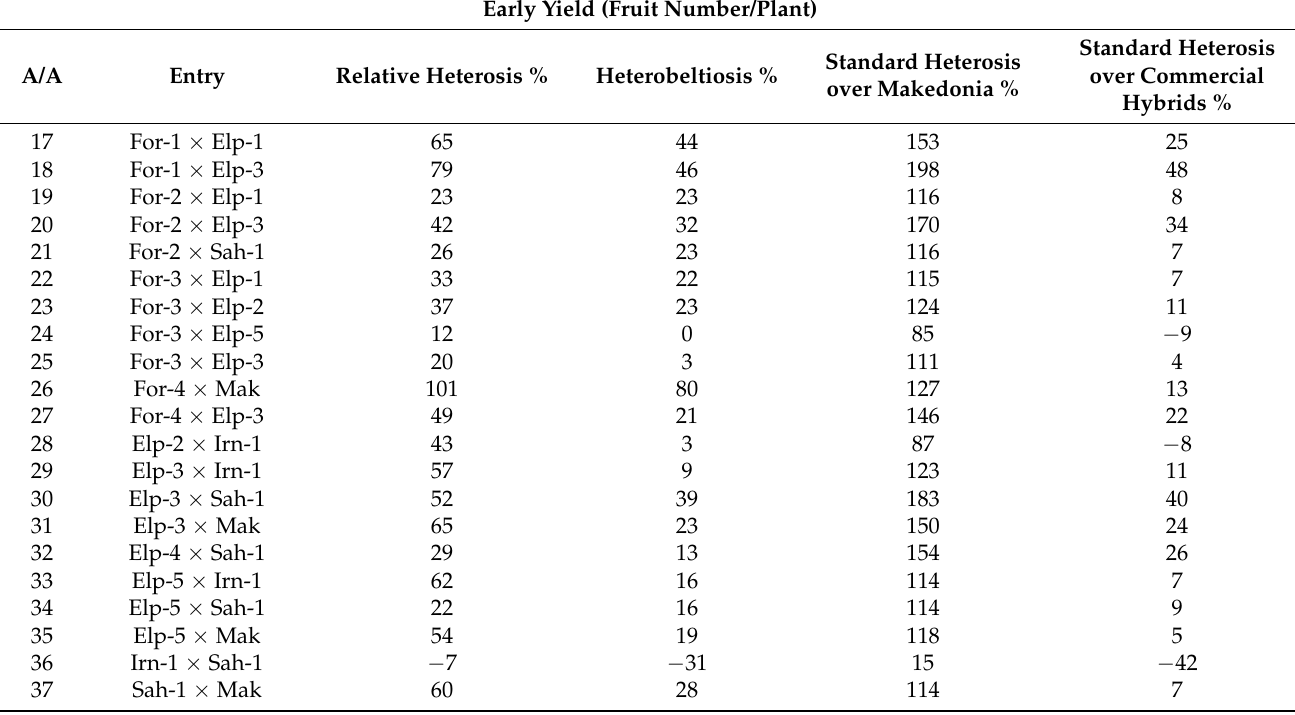
Table 6. Relative heterosis, heterobeltiosis, and standard heterosis of the reconstructed new hybrids for early yield (fruit